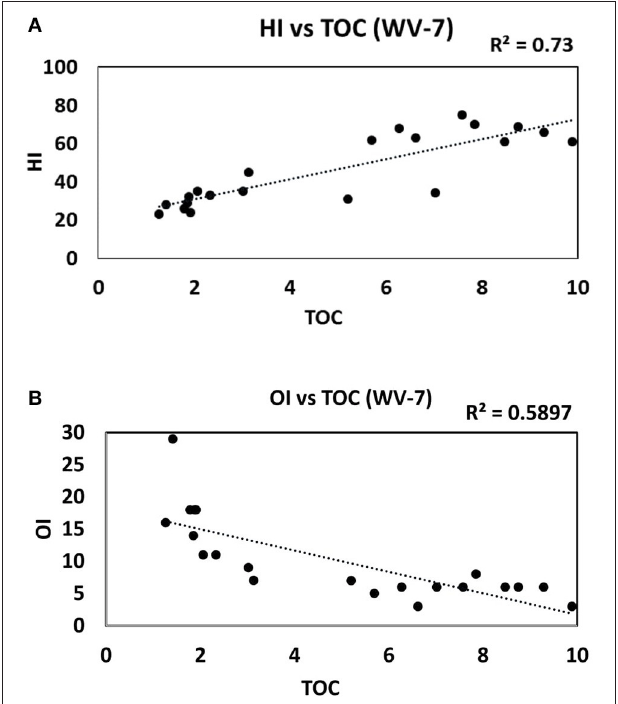
FIGURE 10 | (A) HI vs. TOC and (B) OI vs. TOC plots for WV-6